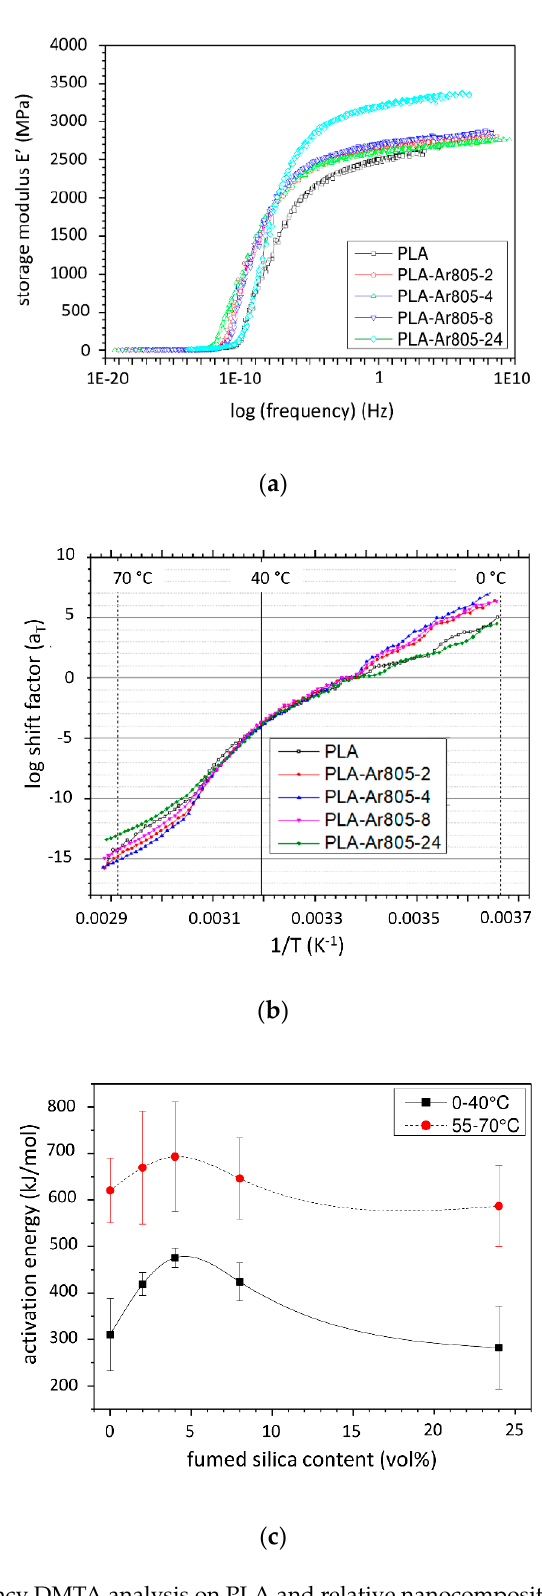
Figure 9. Multifrequency DMTA analysis on PLA and relative nanocomposites. ( a ) Master curves of storage modulus, ( b ) shift factor as a function of the temperature (at T 0 = 30 ◦ C), ( c ) activation energy of shift factor below and above T g as a function of the filler content, calculated from Equation (4).